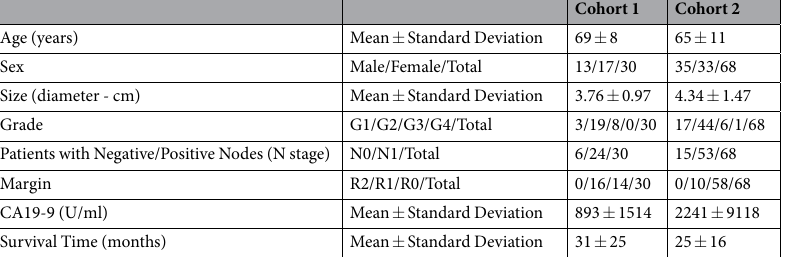
Table 1. Cohorts’ demographic